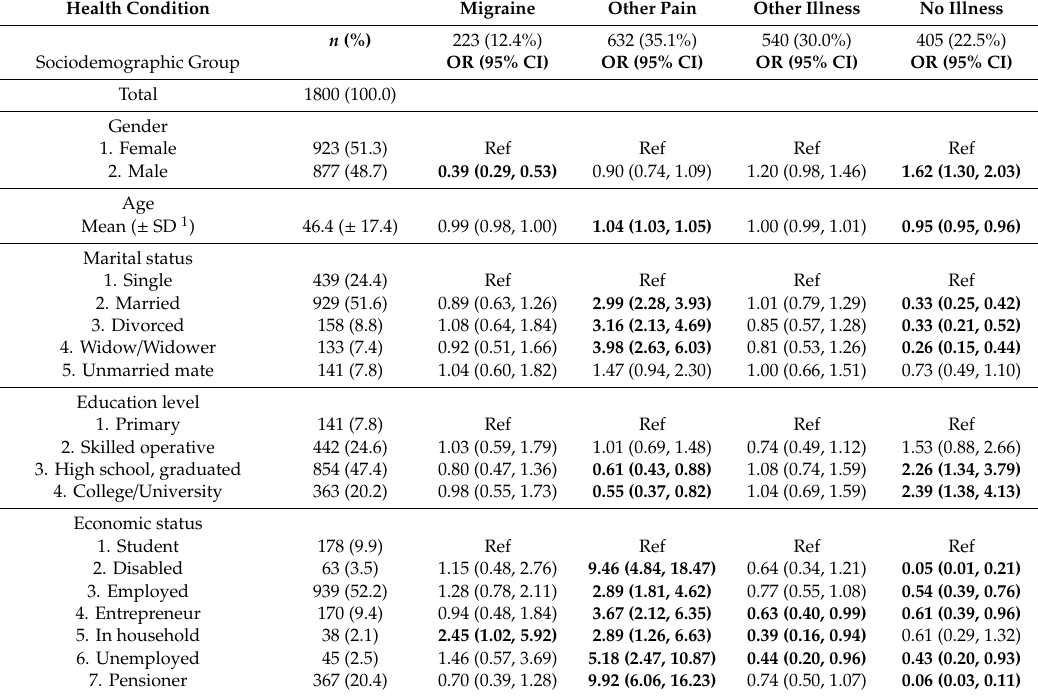
Table 1. Sociodemographic characteristics of the sample and unadjusted odds ratios acquired from logistic